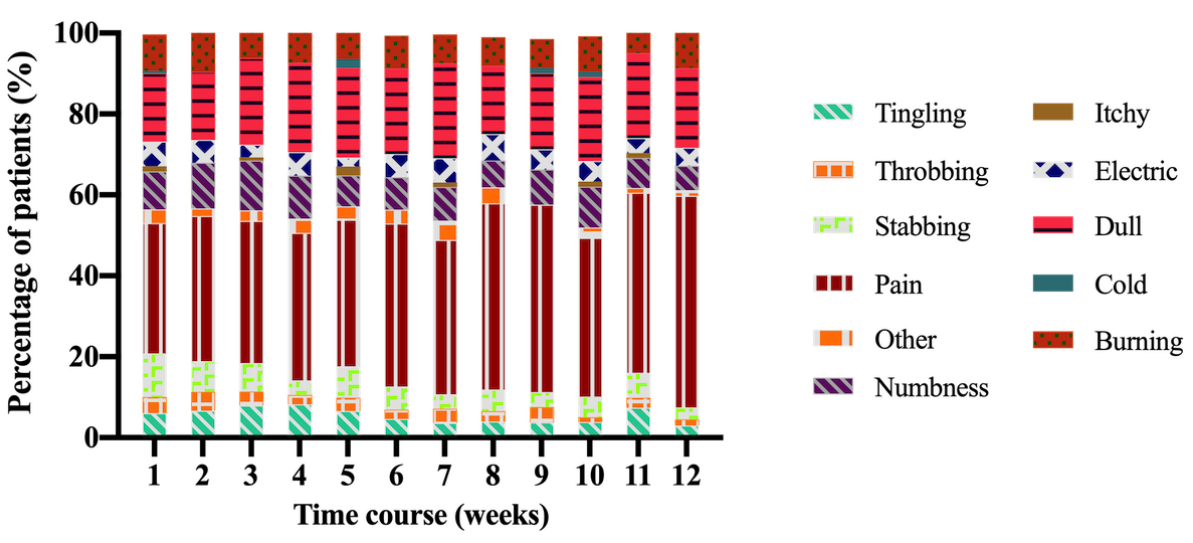
Figure 3. The most frequently selected pain and discomfort quality descriptors over 12 weeks were pain (39%) and dull (20%). The qualities numbness (9%), burning (8%), and stabbing (6%) were also chosen frequently. The least frequently selected quality descriptors were throbbing (3.2%), other (2.8%), itchy (0.8%), and cold